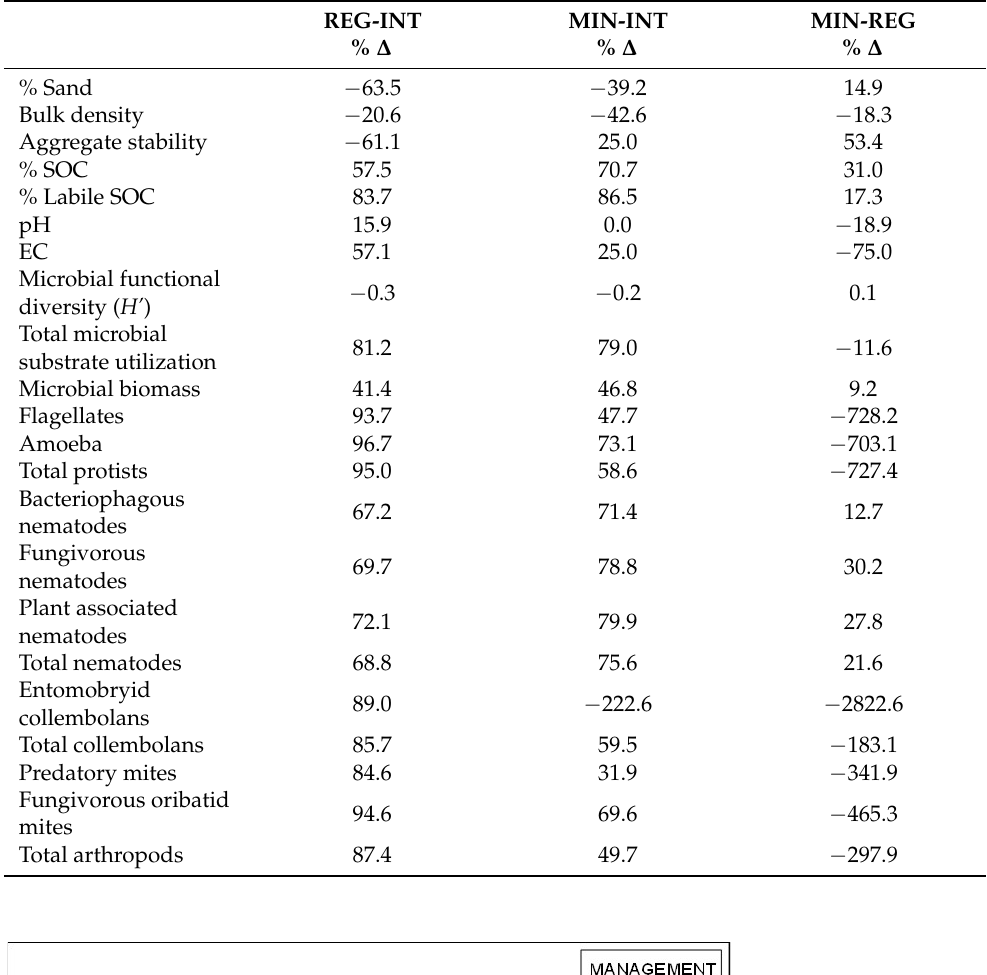
Table 2. Percentage difference (% ∆ ) between pairs of vineyards for all the selected indicators. INT: intensive vineyard; REG: regenerative vineyard; MIN: minimum impact vineyard. .